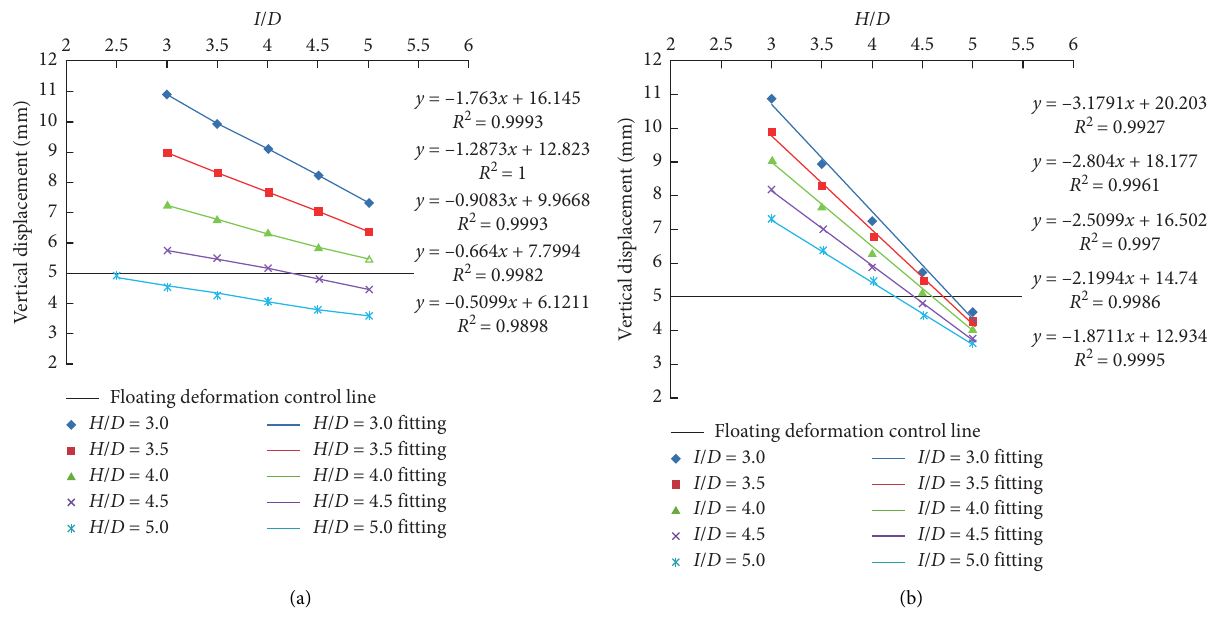
Figure 9: Variation of the maximum value of vertical deformation with H / D and I / D respectively. (a) Variation of the maximum vertical deformation of each working condition with I / D under different H / D . (b) Variation of the maximum vertical deformation of each working condition with H / D under different I / D